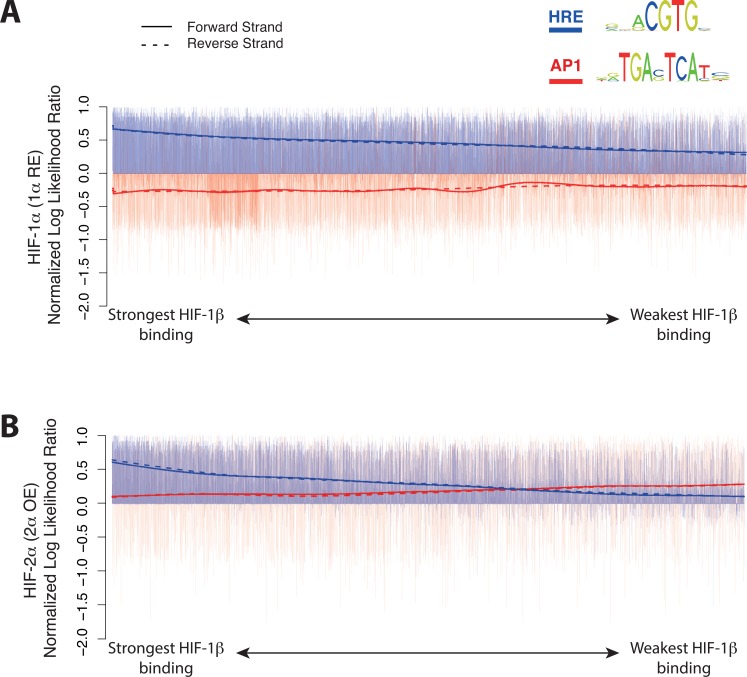
Preferential distribution of AP-1 binding motifs at HIF-2α versus HIF-1α binding loci.In addition to a hypoxia response element (HRE) motif, analysis of sites binding endogenous and overexpressed HIF-2α also identified an AP-1 motif. For each site, the maximum normalized log likelihood ratio for the AP-1 motif in red and the HRE motif in blue is plotted on the vertical axis as a bar chart. A smooth spline cubic fit line is overlaid to show the trend. The smoothing parameter is automatically determined using a ‘leave-one-out’ cross validation as implemented by the Smooth.spline function in R. Sites were categorized as binding (A) re-expressed HIF-1α, (B) overexpressed HIF-2α and ranked according to the HIF-1β signal at each site. Spline fit curves are overlaid (solid/dashed lines) to indicate overall trends across both forward and reverse strands. (A) Sites binding re-expressed HIF-1α show specific enrichment (positive score) for the HRE motif that decreases as the HIF-1β signal falls. In contrast, these same sites show depletion of the AP-1 motif. (B) Sites binding overexpressed HIF-2α show enrichment of the HRE motif that declines more steeply as the HIF-1β signal falls. In contrast to sites binding re-expressed HIF-1α, those binding overexpressed HIF-2α show enrichment of the AP-1 motif that increases (and exceeds that seen for the HRE) as the HIF-1β signal falls.